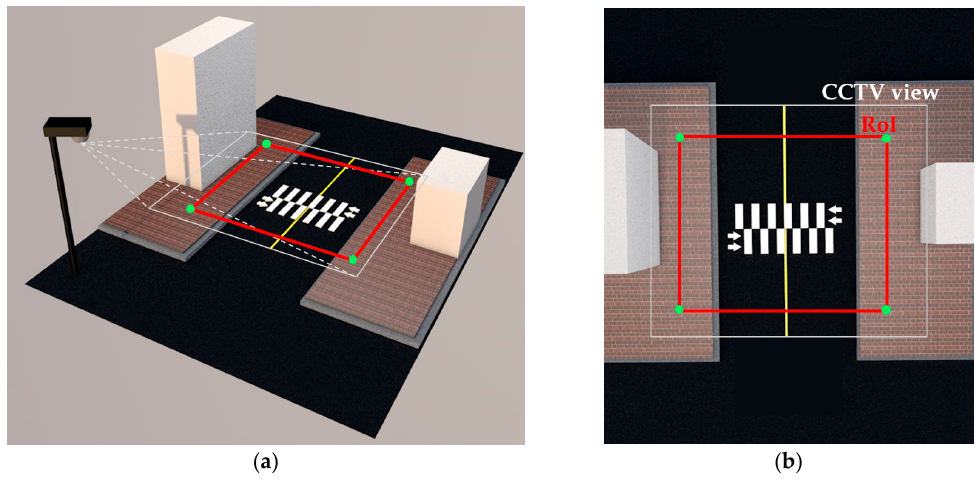
Figure 5. Example of perspective transform from ( a ) oblique view; into ( b ) overhead view.